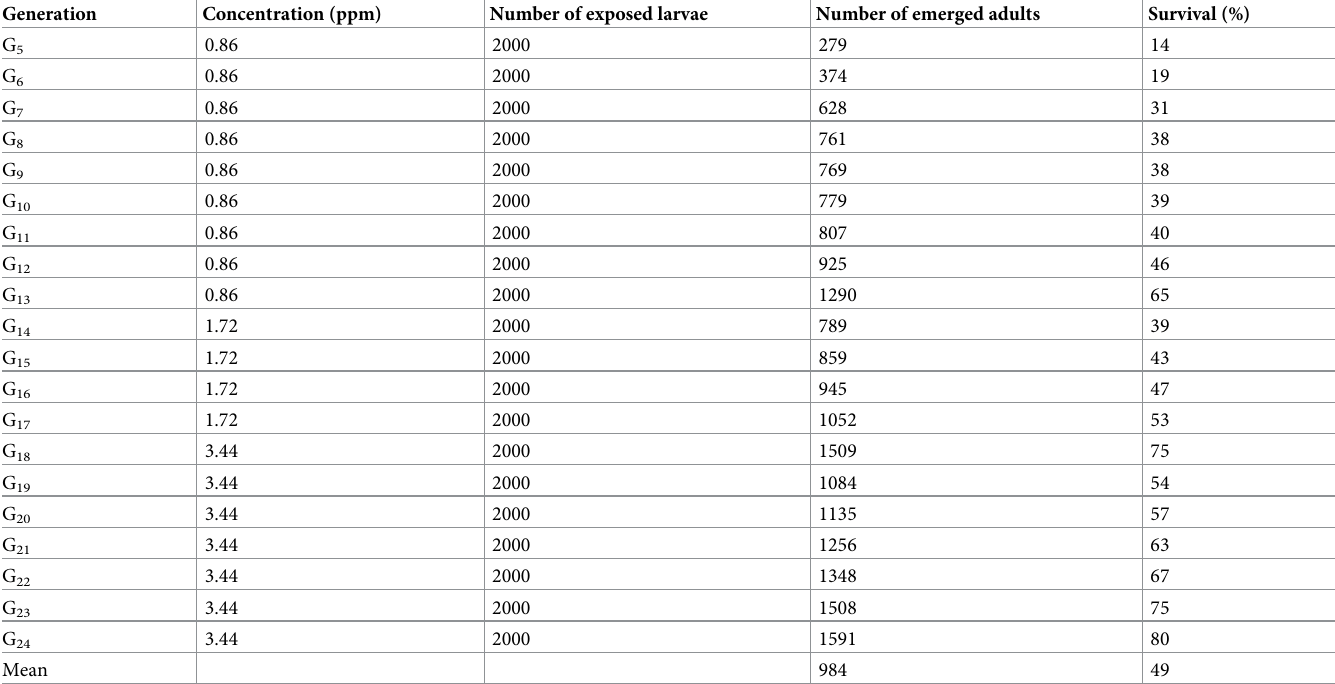
Selection was not performed from G 1 –G 4